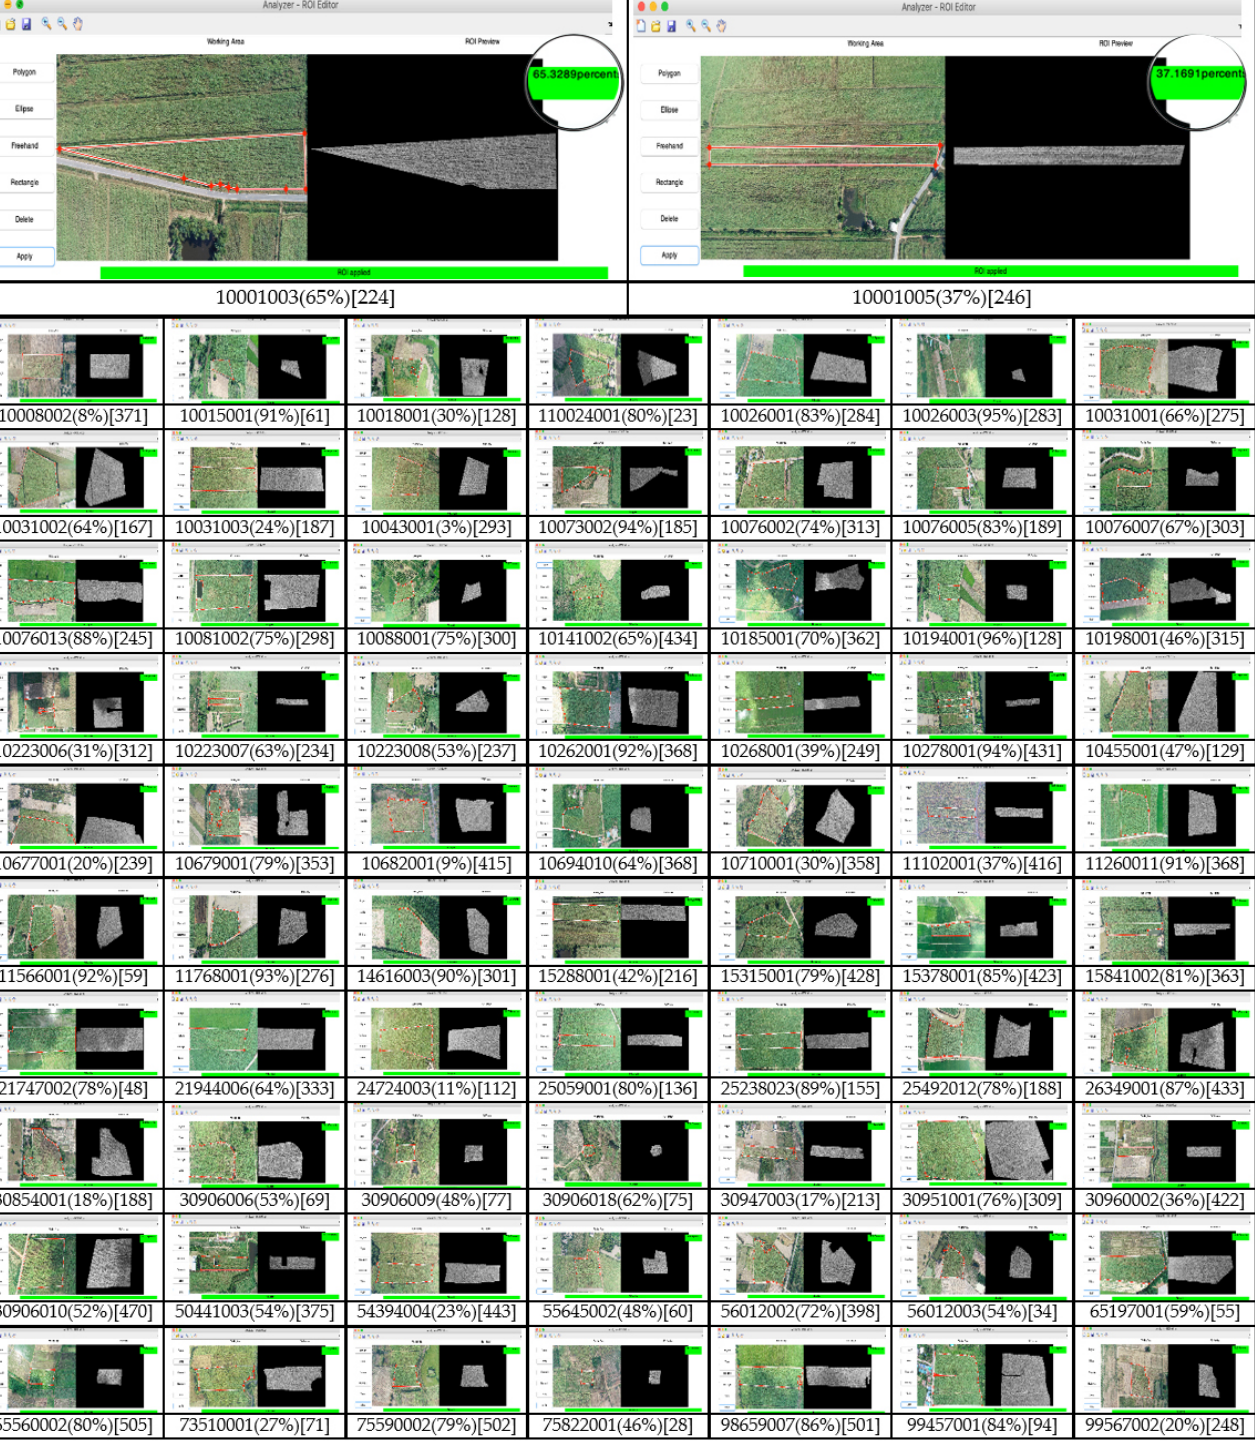
Figure 6. The sugarcane defect detection program’s defect analysis for images in